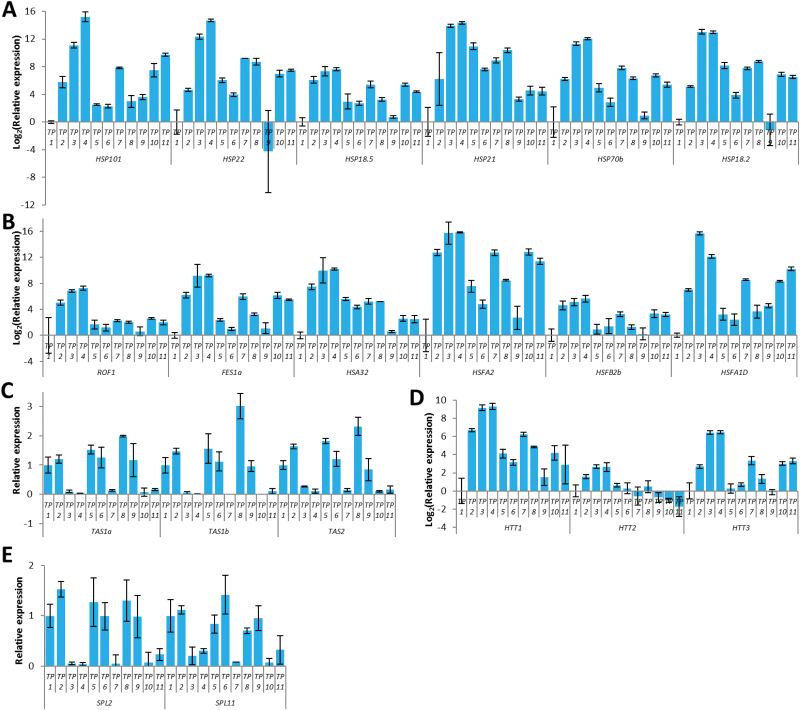
Expression of heat-responsive genes. (A) Heat-shock protein (HSP) genes show up-regulation by heat stress and priming, and most of them maintain higher expression levels for 4 d (time-point 6, TP6) than were observed before heat stress or priming (TP1 and TP9). (B) Heat-shock factors (HSFs) and heat-responsive marker genes show up-regulation by heat stress and priming. (C, D) trans-acting siRNA precursors 1a (TAS1a), TAS1b, and TAS2 are down-regulated by heat stress (C), whereas their target genes, HEAT-INDUCED TAS1 TARGET1 (HTT1), HTT2, and HTT3 are induced during heat stress (D). (E) Targets of miR156, SPL2, and SPL11 genes are down-regulated by heat stress. See Fig. 1 for the temperature regime. (This figure is available in colour at JXB online.)